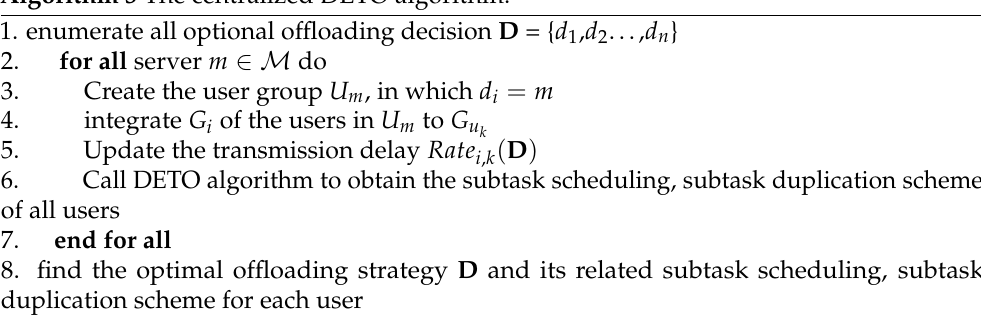
Algorithm 3 The centralized DETO